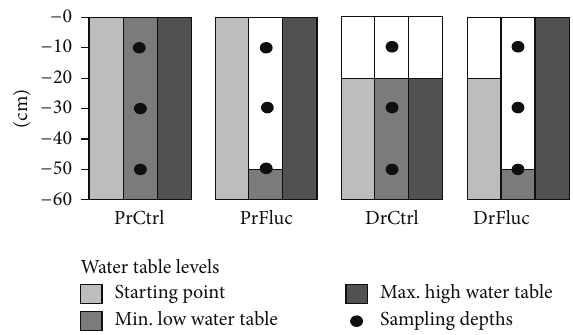
Figure 1: Schematic presentation of the mesocosms. Pr = pristine, Dr = drained, Ctrl = control, and Fluc = fluctuating water